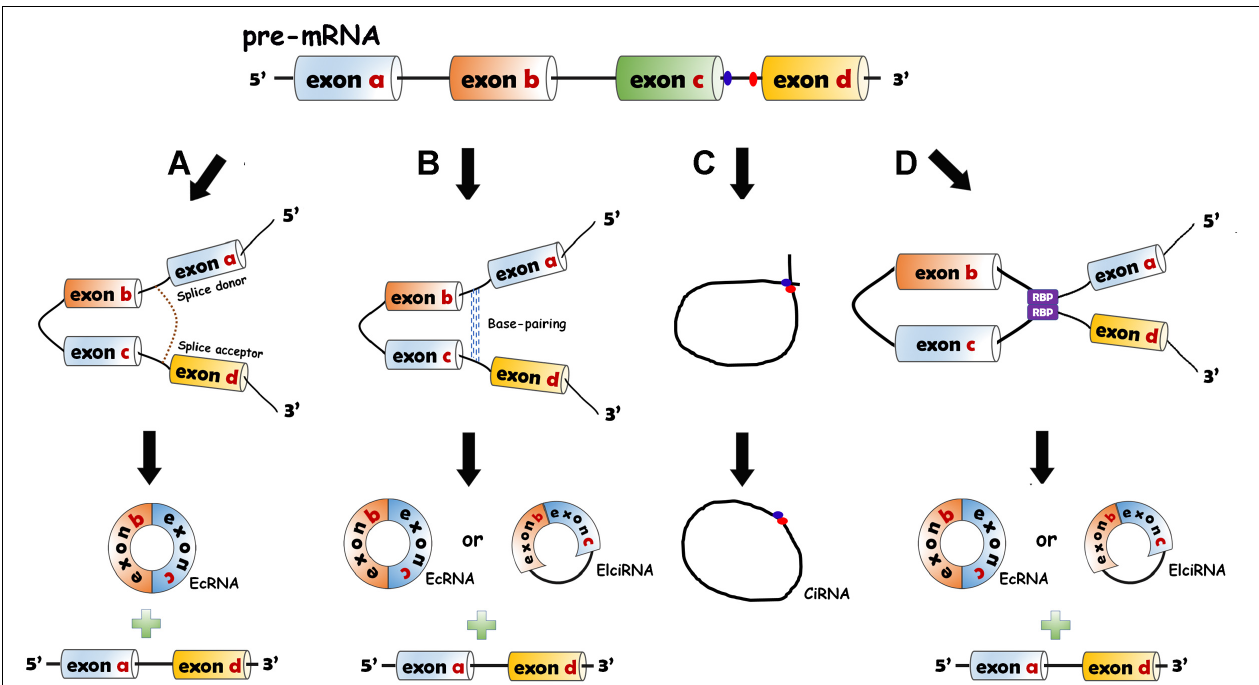
FIGURE 1 | Biogenesis models of circRNAs. (A) Lariat-driven circularization model. The 5 (cid:48) end of the intron (splice donor site, GU) and the 3 (cid:48) end of the intron (splice acceptor site, AG) are covalently bound to generate an exon-containing lariat (one or more exons) which is internally spliced to form EcRNA. (B) Intron-pairing-driven circularization model. The RNA base motifs (e.g., Alu repeats) in the introns of pre-mRNA pair with the complementary sequences and the direct cyclization happens to generate ecRNAs or exon–intron circRNAs (EIciRNAs). (C) Circular intronic RNA (ciRNA) formation. The intron lariat is produced by backsplicing process. C-rich element close to the branch and the GU-rich element near the 5 (cid:48) splice site bind together. The other exons and introns are removed by the spliceosome. (D) RNA binding protein (RBP)-driven model. The bridging of RBPs with pre-mRNAs can give rise to the production of circRNAs (ecRNAs or